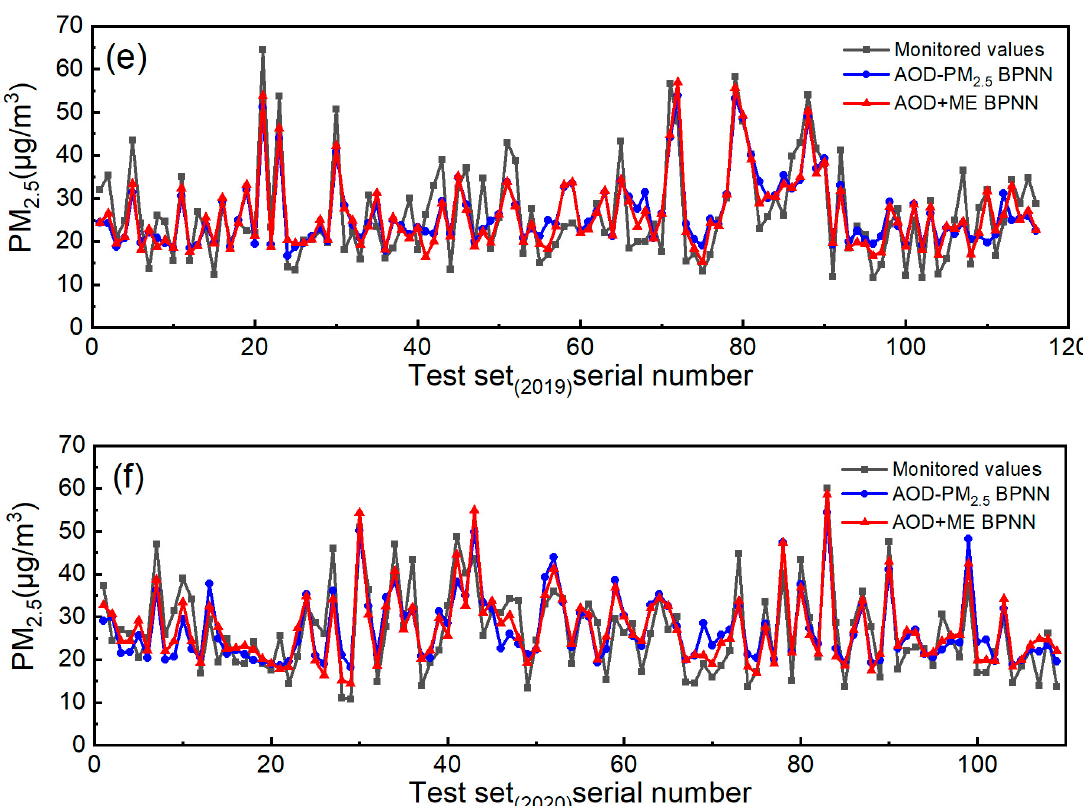
Figure 11. ( a )–( f ) Simulation diagram of PM 2.5 estimated and monitored values of test set. ( a ) 2015 as the test set. ( b ) 2016 as the test set. ( c ) 2017 as the test set. ( d ) 2018 as the test set. ( e ) 2019 as the test set. ( f ) 2020 as the test set .